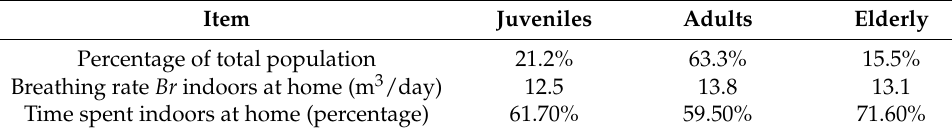
Table A1. Population composition and related factors for exposure assessment.